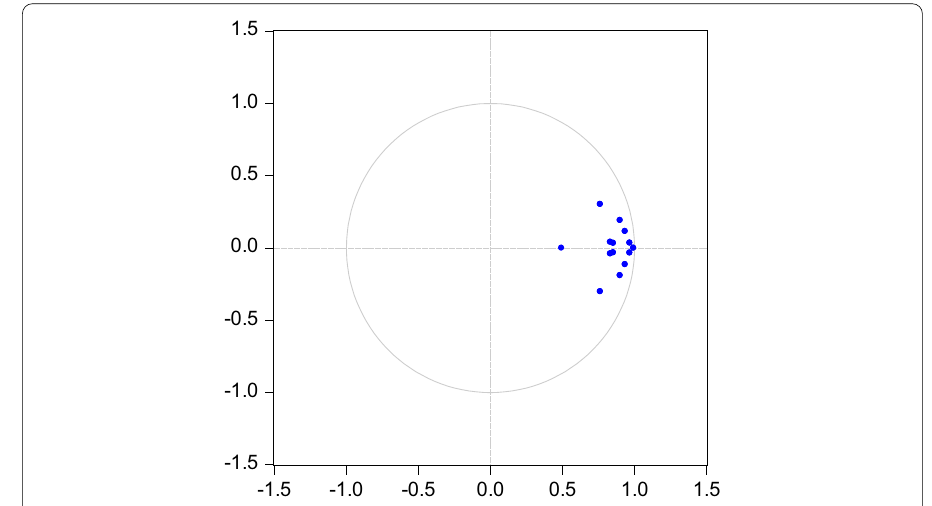
Fig. 5 Inverse roots of AR characteristic polynomial. Source : Authors’ calculations